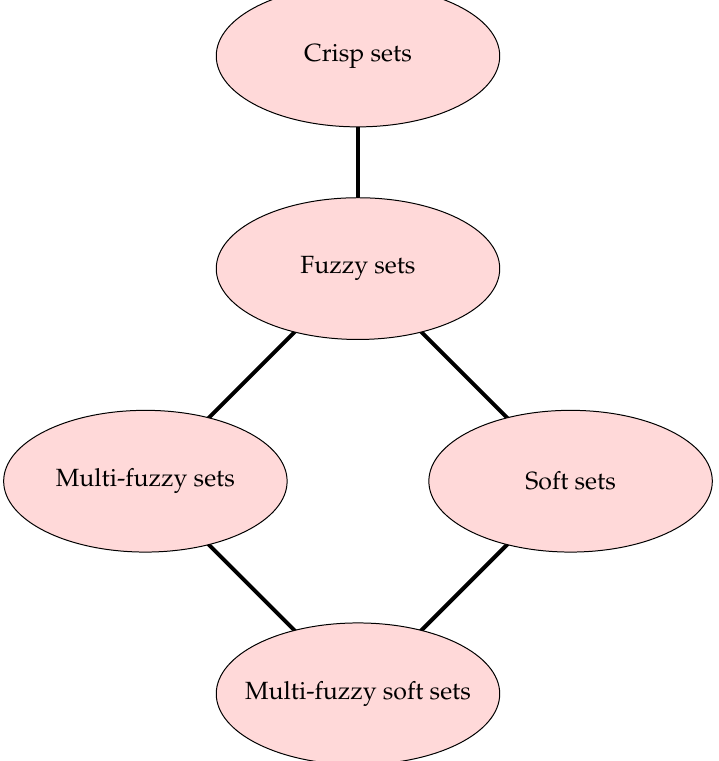
Figure 1. The relation between generalization of crisp